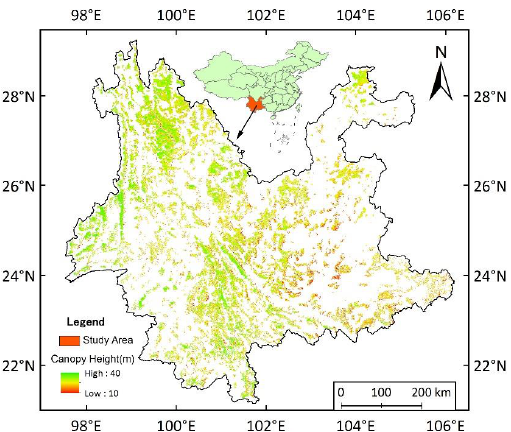
Figure 1. The distribution and canopy heights of forested area in Yunnan Province, southwest China, at a resolution of 1 km [21]. The white region represents the nonforest area.